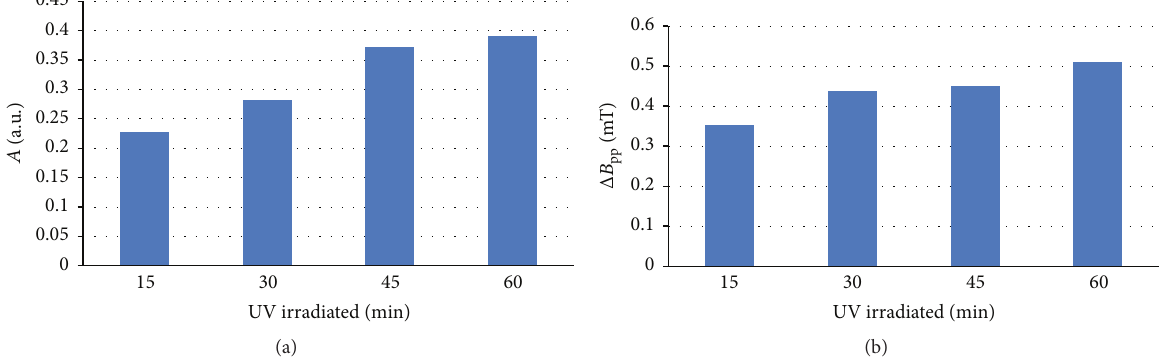
amplitudes ( 𝐴 ), the basic parameters of the EPR spectra, were